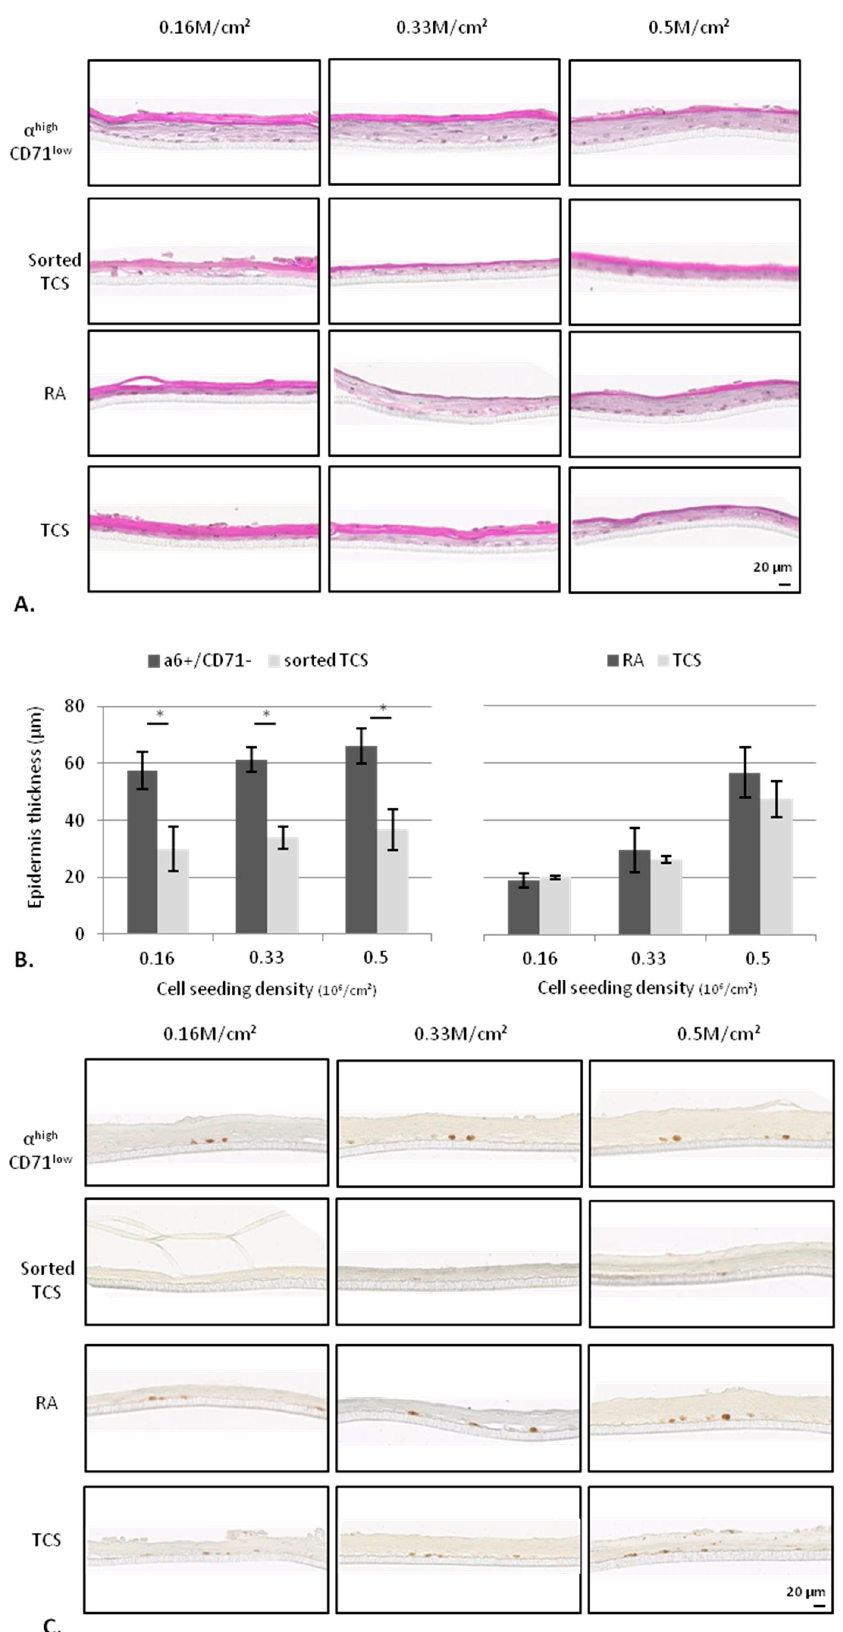
Figure 8. Cont. Figure 8.